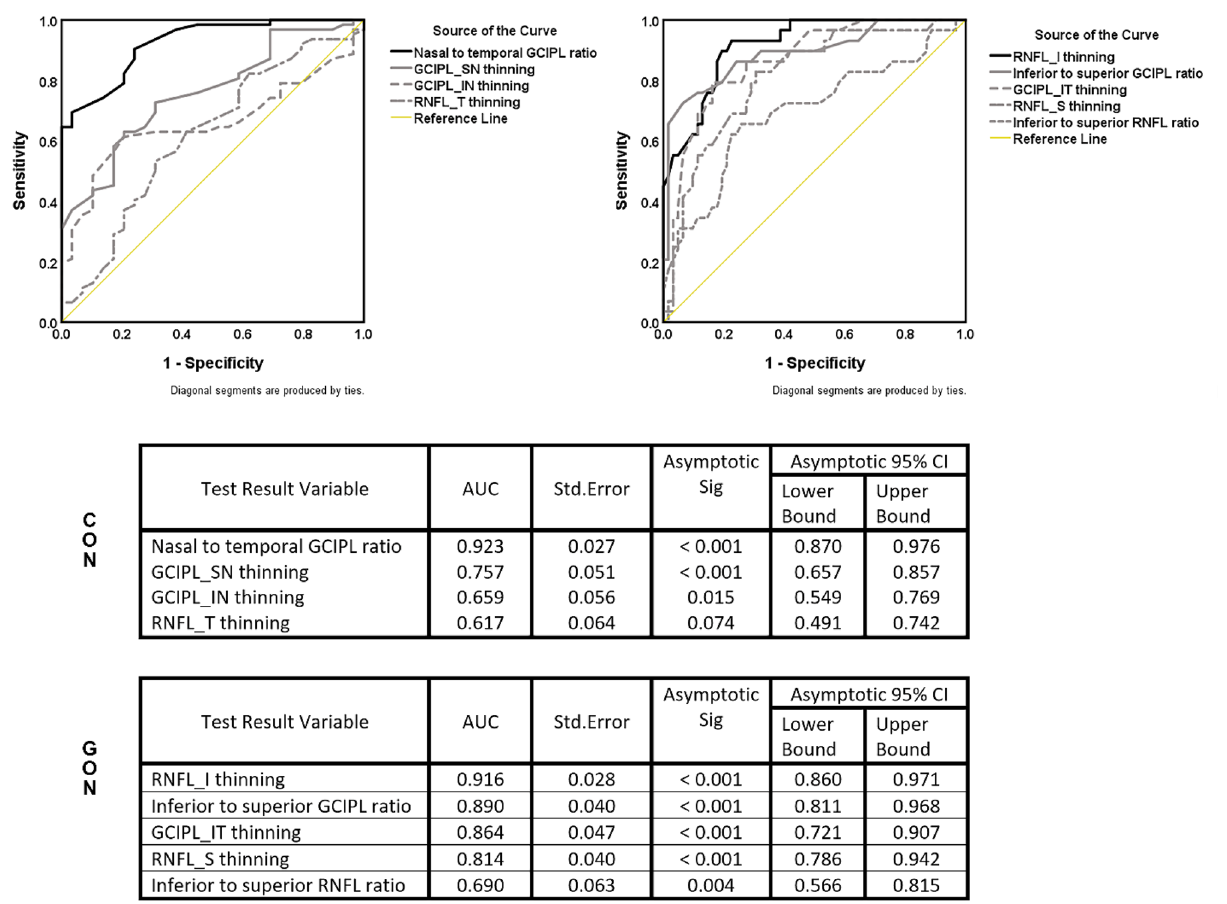
Figure 4. An ROC analysis of both GON- and CON- specific thinning parameters and their specific thinning pattern (ratio) parameters shows the comparative differentiating abilities toward GON and CON diagnosis among eyes with all stages of CON and GON. GON glaucomatous optic neuropathy, CON compressive optic neuropathy, RNFL retinal nerve fiber layer, S superior quadrant, I inferior quadrant, T temporal quadrant, GCIPL ganglion cell-inner plexiform layer, SN supero-nasal sector, IN infero-nasal sector, IT infero-temporal sector, AUC area under curve, CI confident